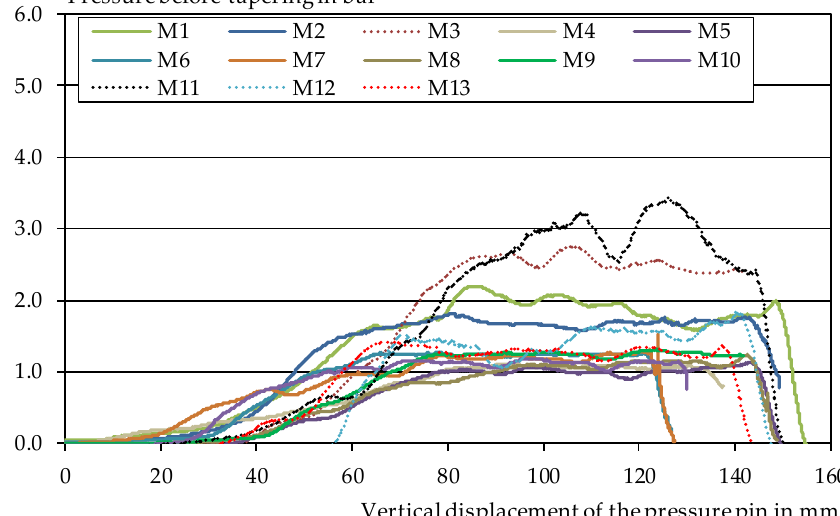
Figure 10. Measured pressure during the test immediately before tapering in the capillary rheometer for all mixtures. Non-extrudable mixtures are shown as dotted lines.